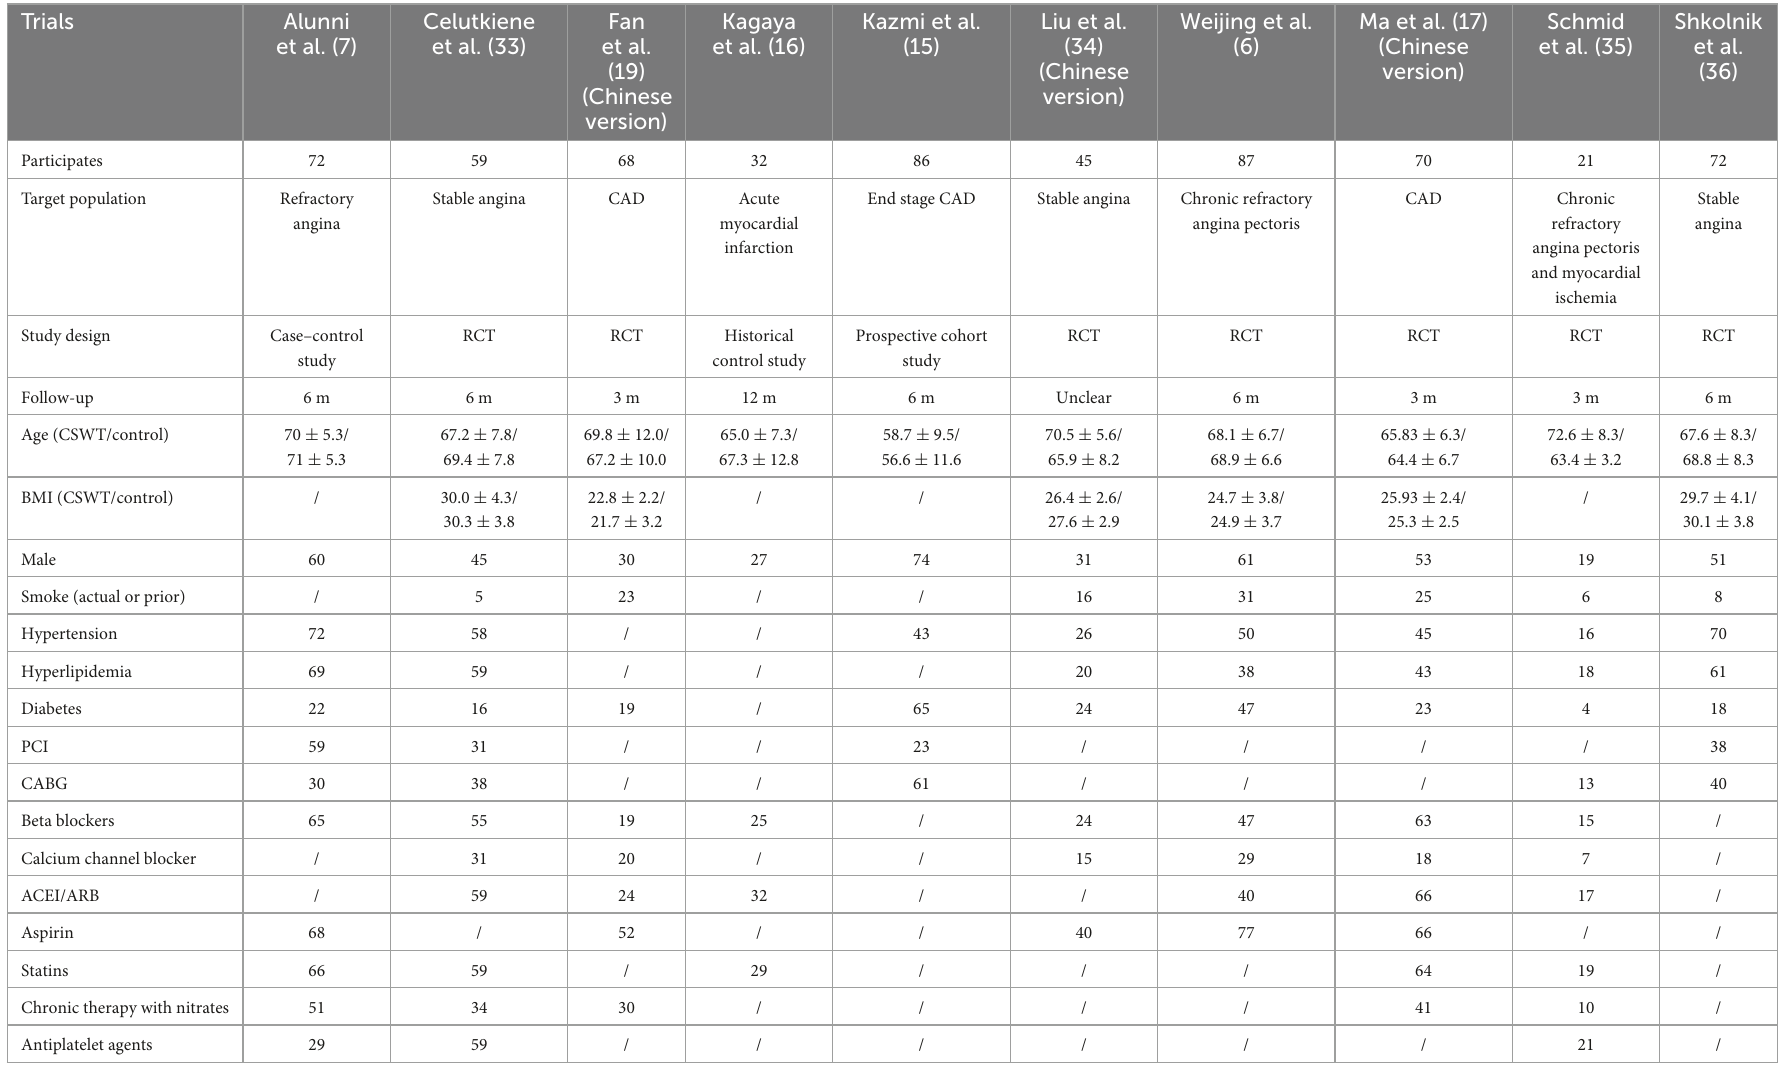
TABLE 1 Characteristics of trials included in the